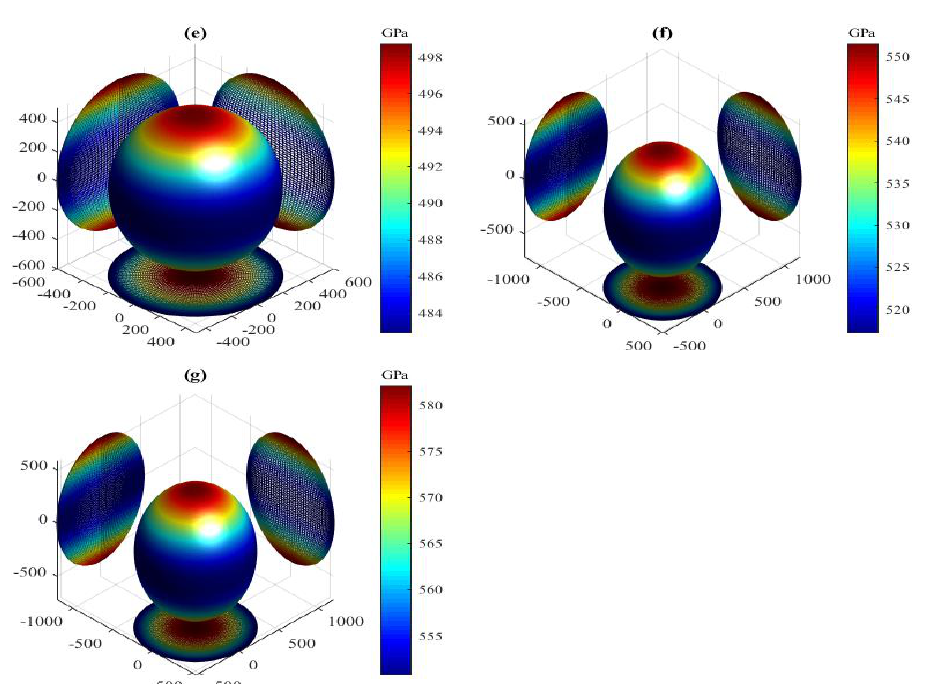
Figure 7. Directional dependence of bulk modulus for the LPS r-Al 2 Ti under pressure ( a ) 0 GPa,